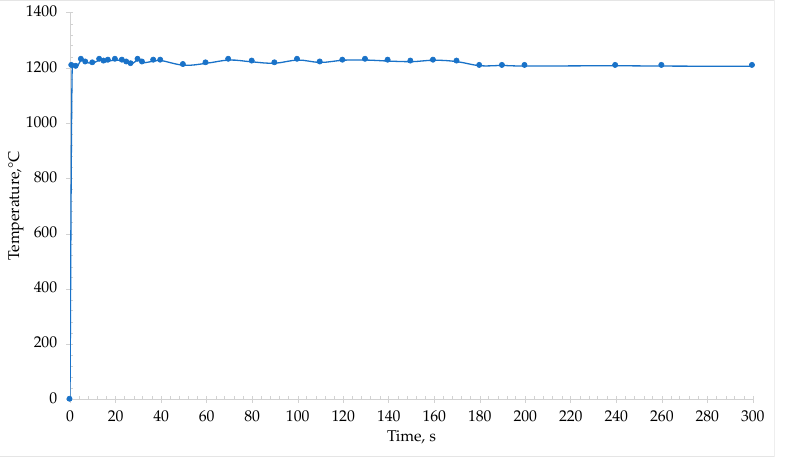
Figure 9. Back electron scattering mode SEM-EDS analysis of the 2nd cinder after the second microwave roasting reduc- tion: ( a ) metallic spheres ( b ) matrix ( c ) dark gray particle on the metallic spheres surface.